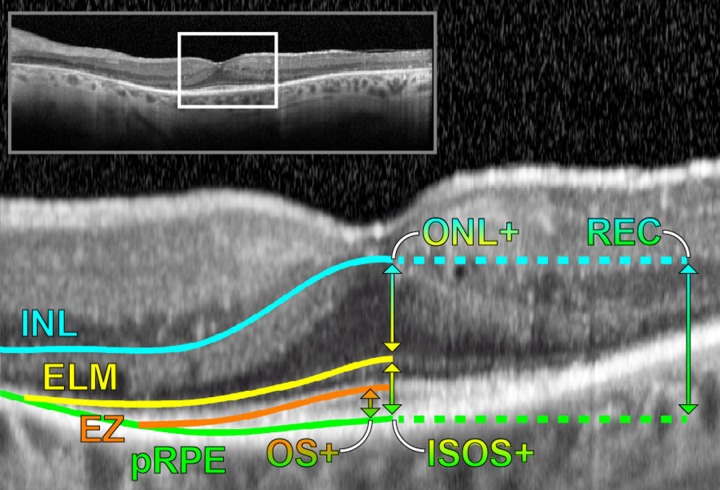
OCT b-scan segmentation.Image from one participant showing the four segmented boundaries and four retinal layers listed in Table 1.